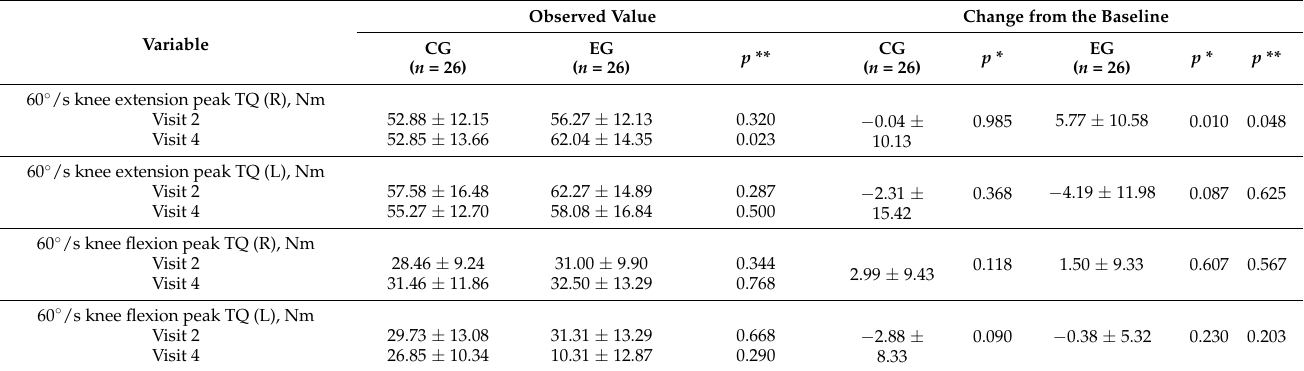
Table 4. Primary outcome comparisons between and within each group (ITT population).